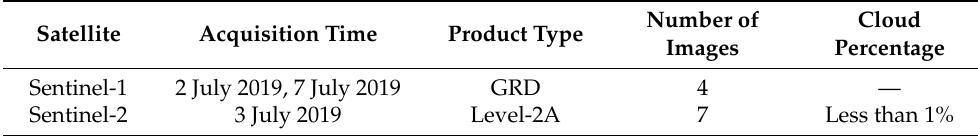
Table 2. Basic information of the Sentinel data used in this study.